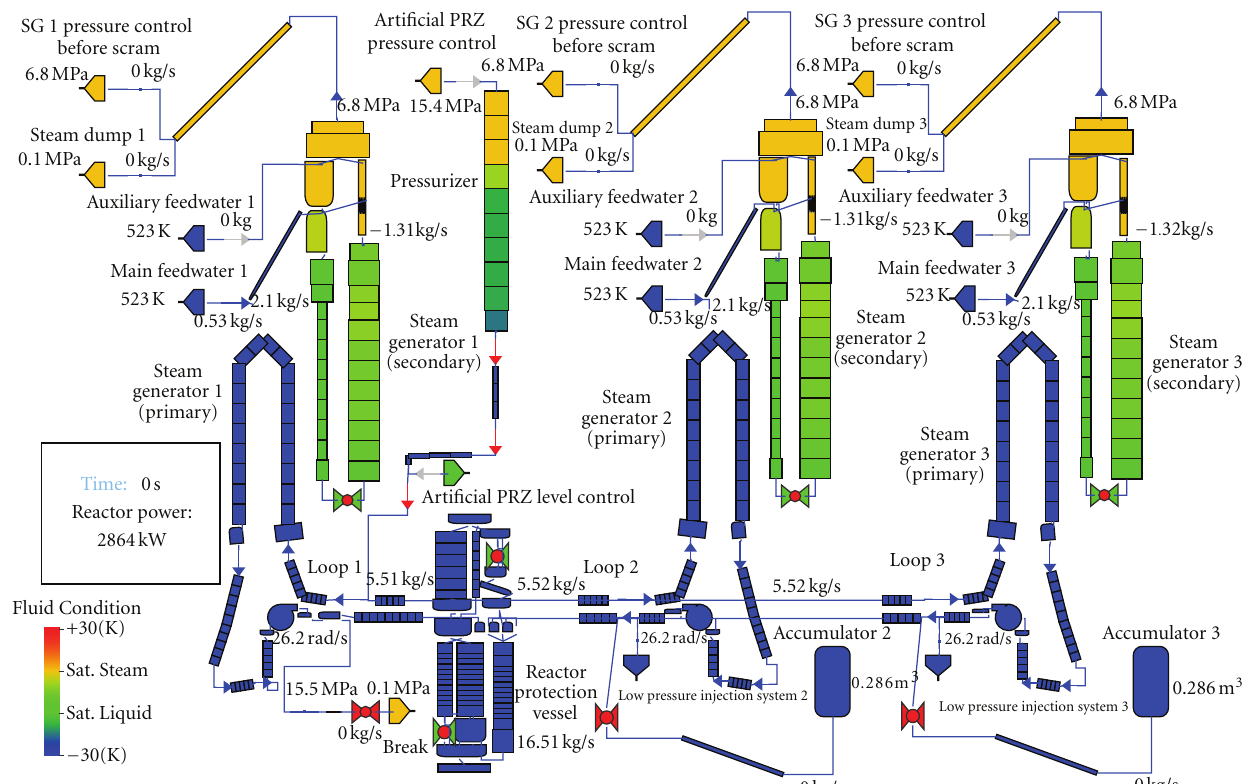
Figure 4: RELAP5 initial and boundary conditions for BETHSY 6.2TC test—animated view.